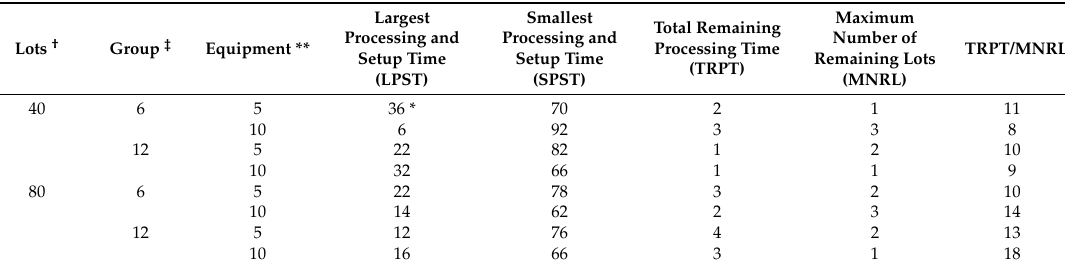
Table 1. Overall